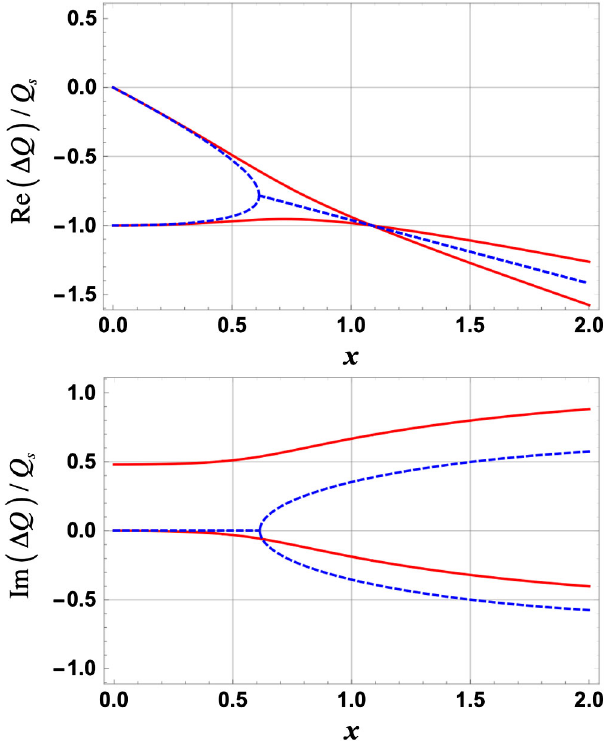
FIG. 4. Solutions of the diagonalization of the 2 by 2 matrix of Eq. (2) vs x a normalized parameter proportional to the bunch intensity [4]: without (dotted blue line) and with (red line) the resistive TD ( Δ Q TD =Q s ¼ 0 . 48 j